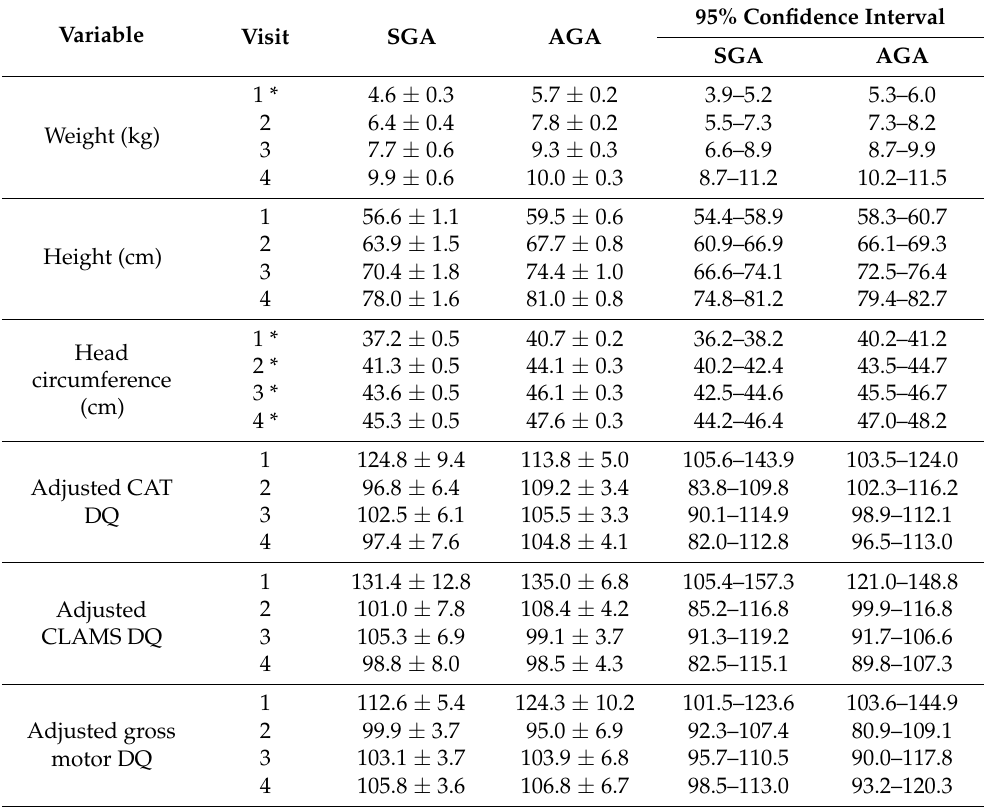
Table 4. Growth and neurodevelopmental scores of SGA and AGA over serial outpatient